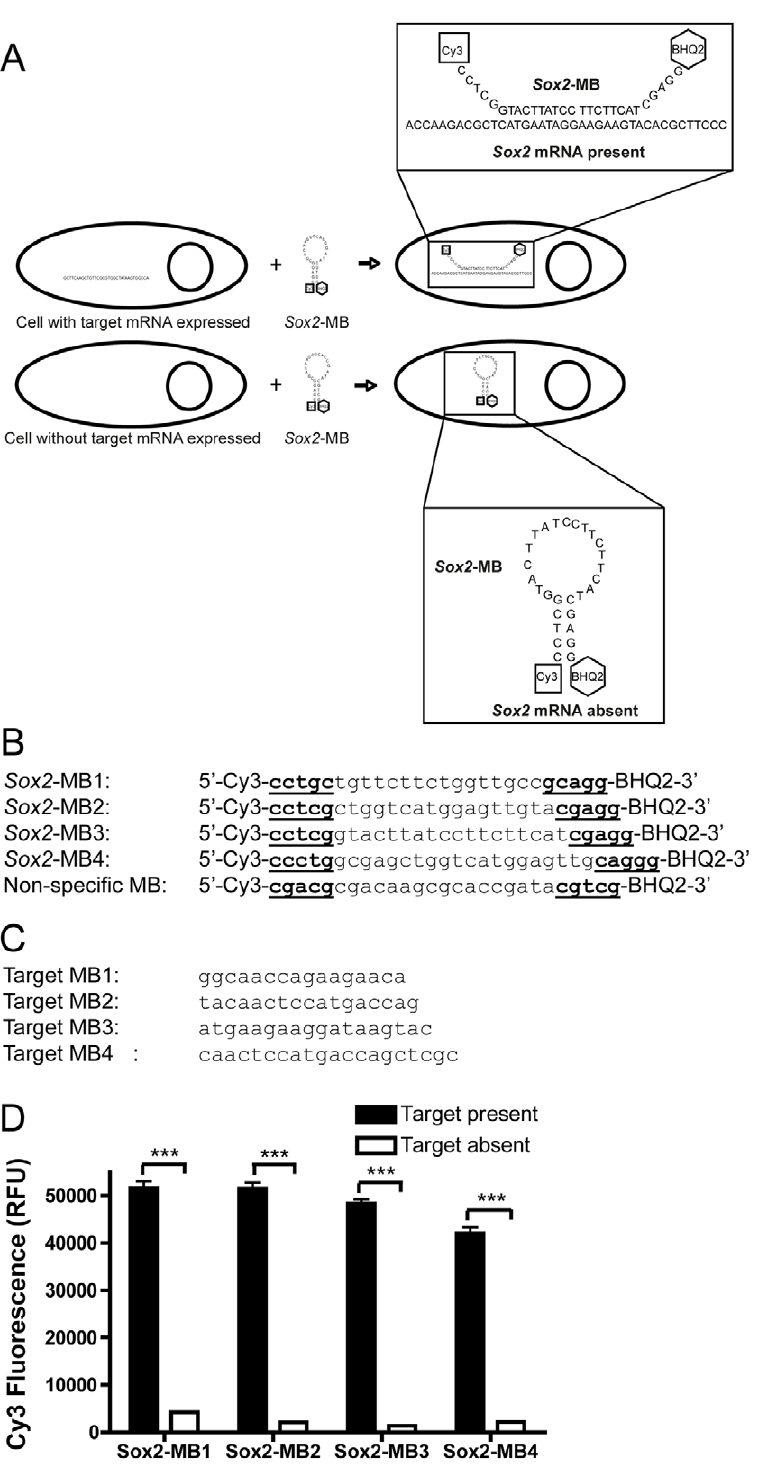
Figure 1. Mechanism and design of Sox2 mRNA-specific MB. (A) Opening of the Sox2 -MB is induced in the cytoplasm of cells expressing Sox2 and emission of Cy3 fluorescence is detected. In contrast, Sox2 -MB remains in the hairpin conformation in the cytoplasm of Sox2 negative cells, and no emission of Cy3 fluorescence is detected. (B) The sequences of the designed Sox2 -MBs and the non-specific-MB. (C) The sequences of the synthesized oligonucleotides complementary to the loop sequence of each Sox2 -MB. (D) The Sox2 -MBs were mixed with or without its target sequence and the Cy3-fluorescence was detected with microplate reader. A difference was seen in all of the designed Sox2 -MBs between when the target sequence was present or not. Error bars represent the mean 6 SEM. Asterisks denote statistical significance (n=3 samples, *** p , 0.001).